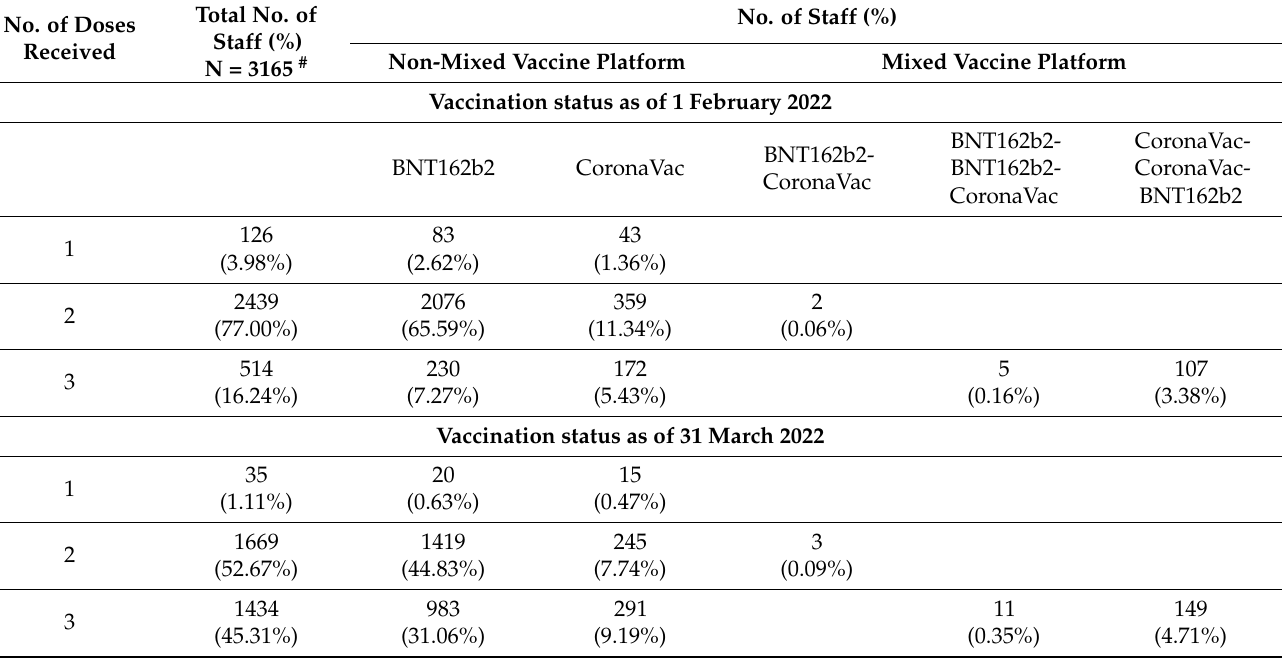
Table 1. Vaccination status of 3167 hospital staff before and at the end of the study period. No. of Doses